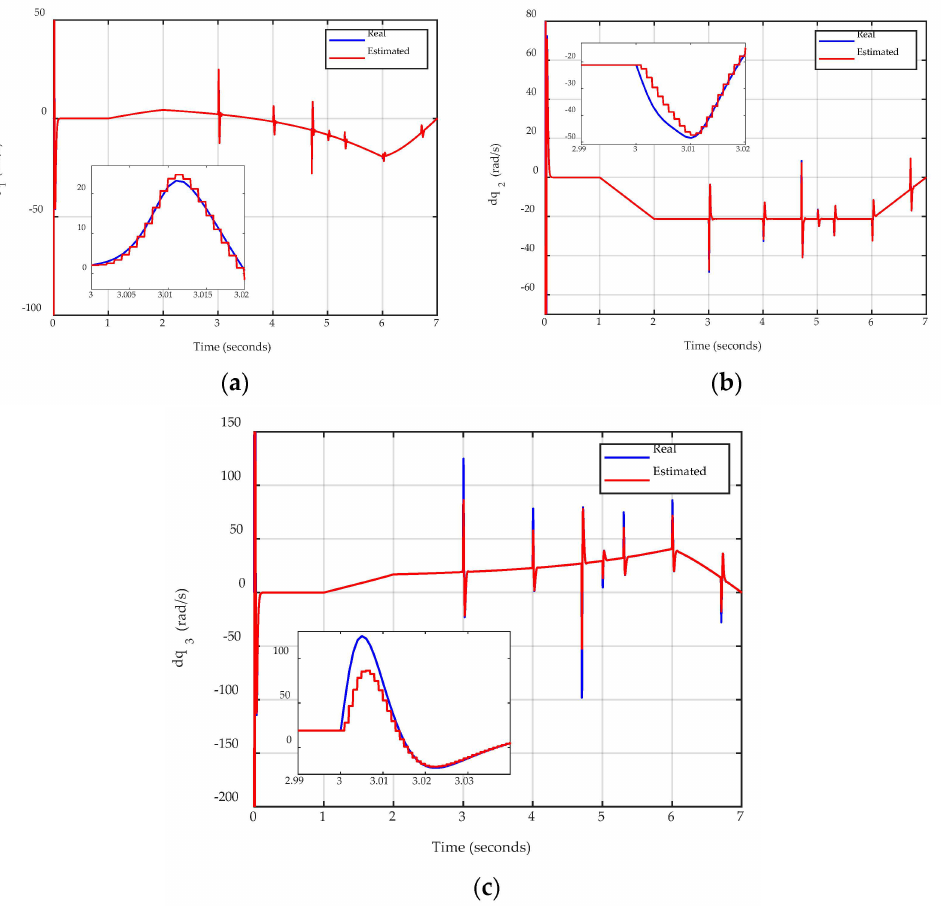
Figure 11. Velocity estimation performance of ( a ) boom, ( b ) arm, and ( c ) bucket in Case